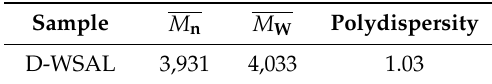
Figure 9. GPC spectrum of D-WSAL prepared under the optimum demethylation condition: 12:1 molar ratio of ICH to lignin, 145 °C, 4 mL DMF, for 3 h under nitrogen atmosphere. Table 8. GPC results of D-WSAL prepared under the optimum demethylation condition (the demethylation process was carried out with 12:1 molar ratio of ICH to lignin, prepared at 145 °C with 4 mL DMF for 3 h under nitrogen atmosphere).